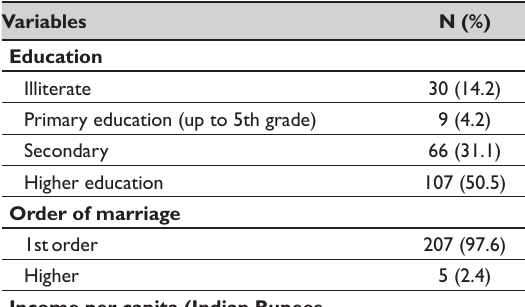
Table 1: Selected